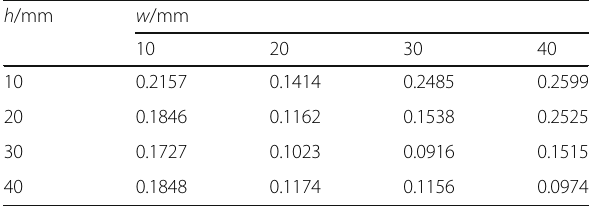
Table 1 The maximum acoustic pressure value of the direct waves with different width w and height h of shielding structure